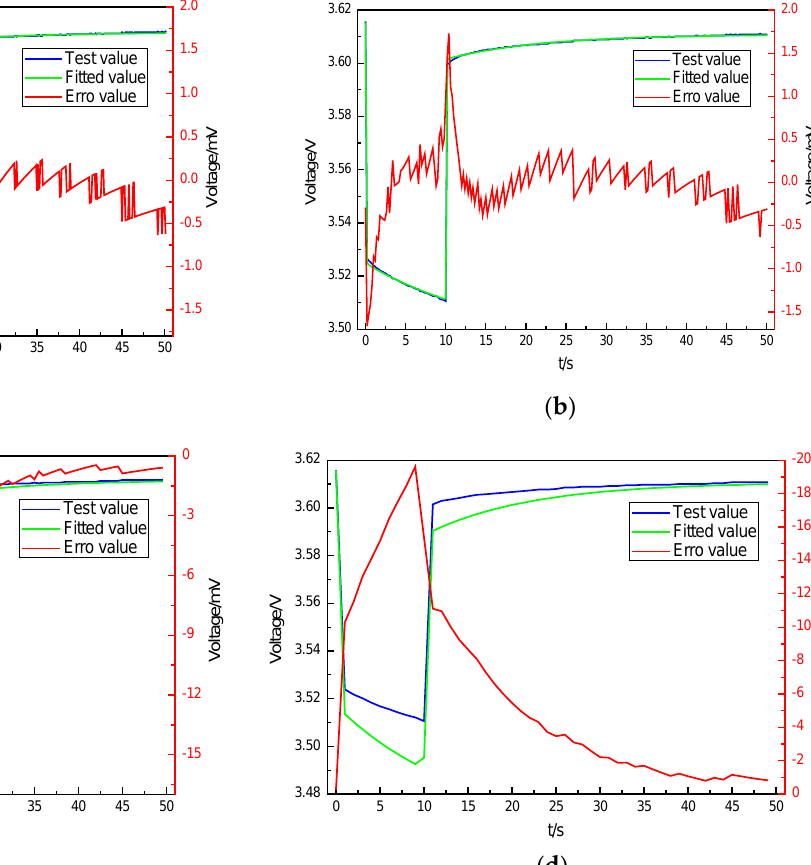
Figure 7. Voltage curves of the discharge and relaxation periods of 1-RC circuit model at SOC = 0.4: Figure 8. Voltage curves of the discharge and relaxation periods of 2-RC circuit model at SOC = 0.4: ( a )  t = 0.1 s; ( b )  t = 0.2 s; ( c )  t = 0.5 s; ( d )  t = 1.0 s.